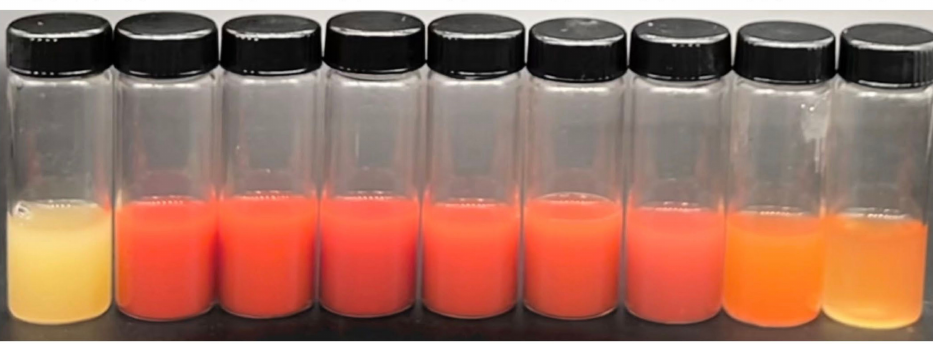
Figure 1. Tolerance of strain Y4 to different concentrations of sodium selenite. Table 1. The selenium tolerance and the ratio of hydrolysis circle diameter of the 16 strains.